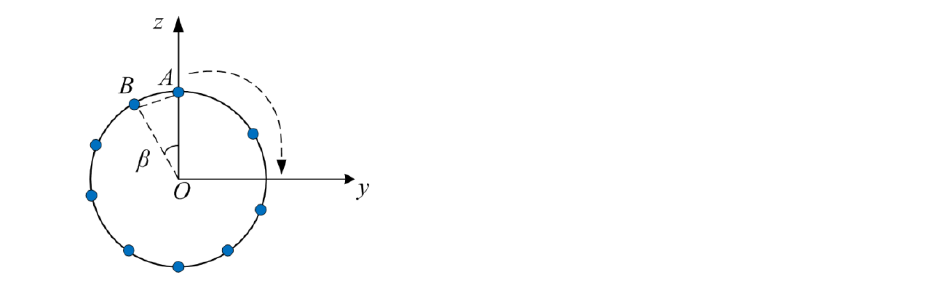
Figure 8. Graphical demonstration of the axis section acquisition point.